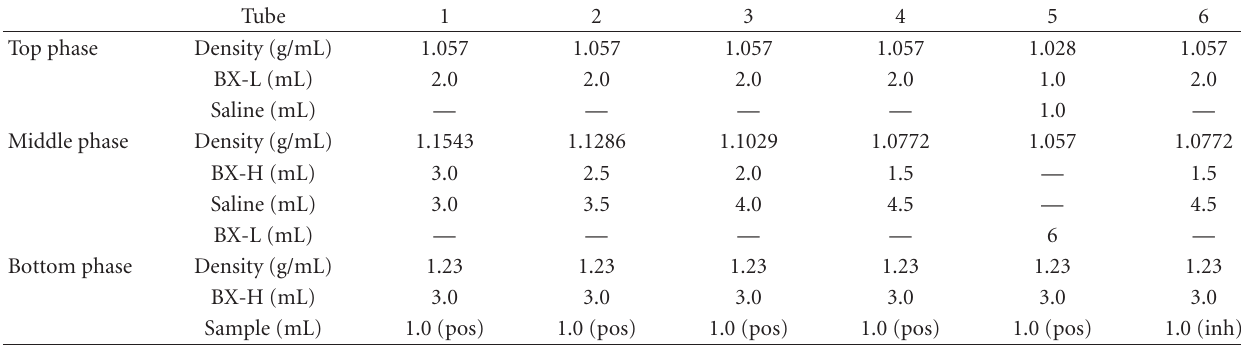
Table 1: The design of six di ff erent density gradient setups to establish a suitable flotation setup for routine analysis of faecal samples. The supernatant from a PCR-positive (pos) or inhibiting (inh) faecal sample was mixed with a high density medium (BX-H) and over layered by two phases of decreasingly lower densities (BX-H mixed with saline, BX-L, or BX-L mixed with saline). Five di ff erent density gradient setups